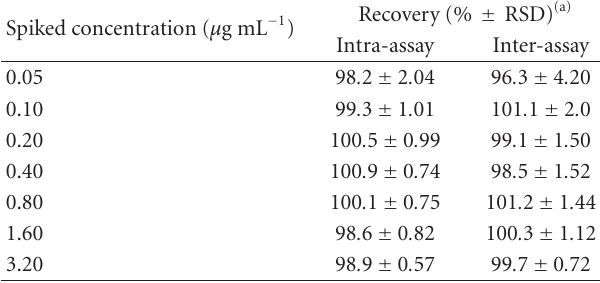
Table 4: Recovery studies for the proposed spectrofluorometric method for the determination of AMD in spiked human plasma.